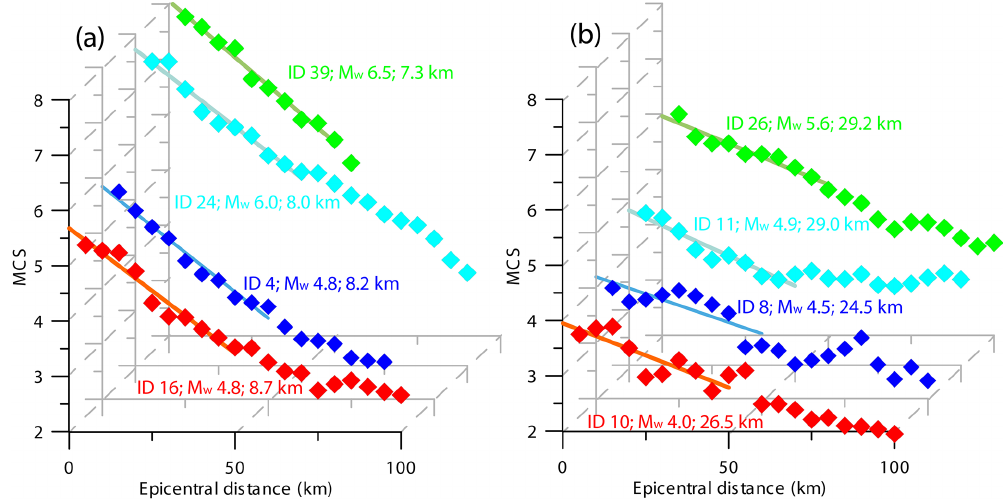
Figure 6. Attenuation curves obtained for two groups of earthquakes featuring a similar hypocentral depth but a different magnitude: (a) for the shallow events of no. 4, no. 16, no. 24, and no. 39 and (b) for the deep events of no. 8, no. 10, no. 11, and no. 26 (see Table 1 for further details). The steepness of the best-fitting line in the first 50km is similar among the four events reported for each group, providing empirical evidence for the independence of inferred depth from magnitude in our